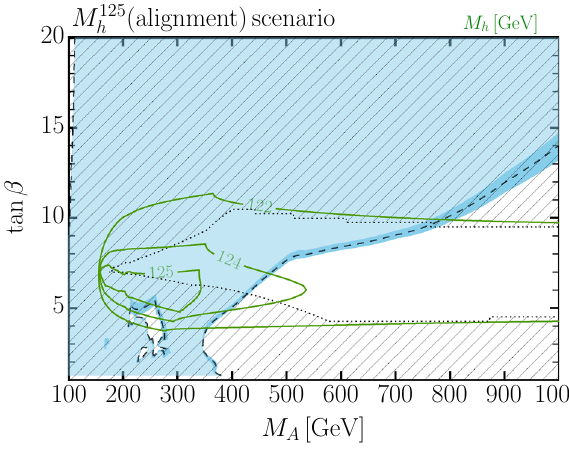
( alignment ) scenario from Higgs Fig. 9 Constraints on the M 125 h searches at the LHC, in the ( M A , tan β) plane. The green solid lines are predictions for the mass of the lighter CP -even scalar h , the hatched area is excluded by a mismatch between the properties of h and those of the observed Higgs boson, and the blue area is excluded by the searches for additional Higgs bosons (the darker-blue band shows the theoretical uncertainty of the exclusion) matically allowed at lower values of M A , their rates would be strongly suppressed by small